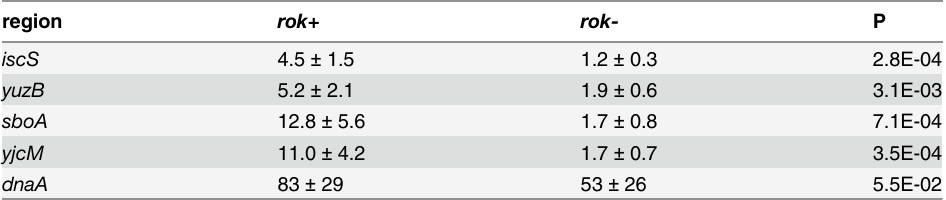
dnaA 1 Wild type ( rok +; AG174) and a rok null mutant ( rok -; HM57) were grown to mid-exponential phase in LB medium. Crosslinking, immunoprecipitation with anti-DnaA antibodies, and PCR with primers to the indicated chromosomal regions were done as described (Materials and Methods). Numbers indicate the fold enrichment of the indicated chromosomal regions in the immunoprecipitate compared to a control chromosomal region ± standard deviation from six independent cultures. P values are from a one-sided Student ’ s t-Test. The effects of rok on DnaA binding are signi fi cant at all loci indicated, except for dnaA .